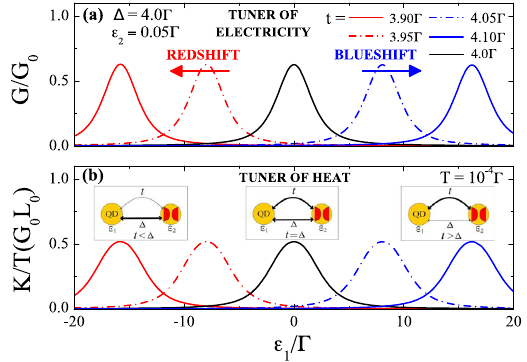
Figure 3. Electrical and thermal conductances as functions of the QD energy level outside SC-metallic boundary phase. Slight deviations from the condition t = Δ result in the shift of the resonance peak for the electrical (panel (a)) and thermal (panel (b)) conductances. The corresponding resonances are blueshifted for t > Δ and redshifted for t < Δ as compared to the case of the SC-metallic boundary phase. Insets show the equivalent circuit with auxiliary fermion d 2 constructed from MFs η A and η B (red